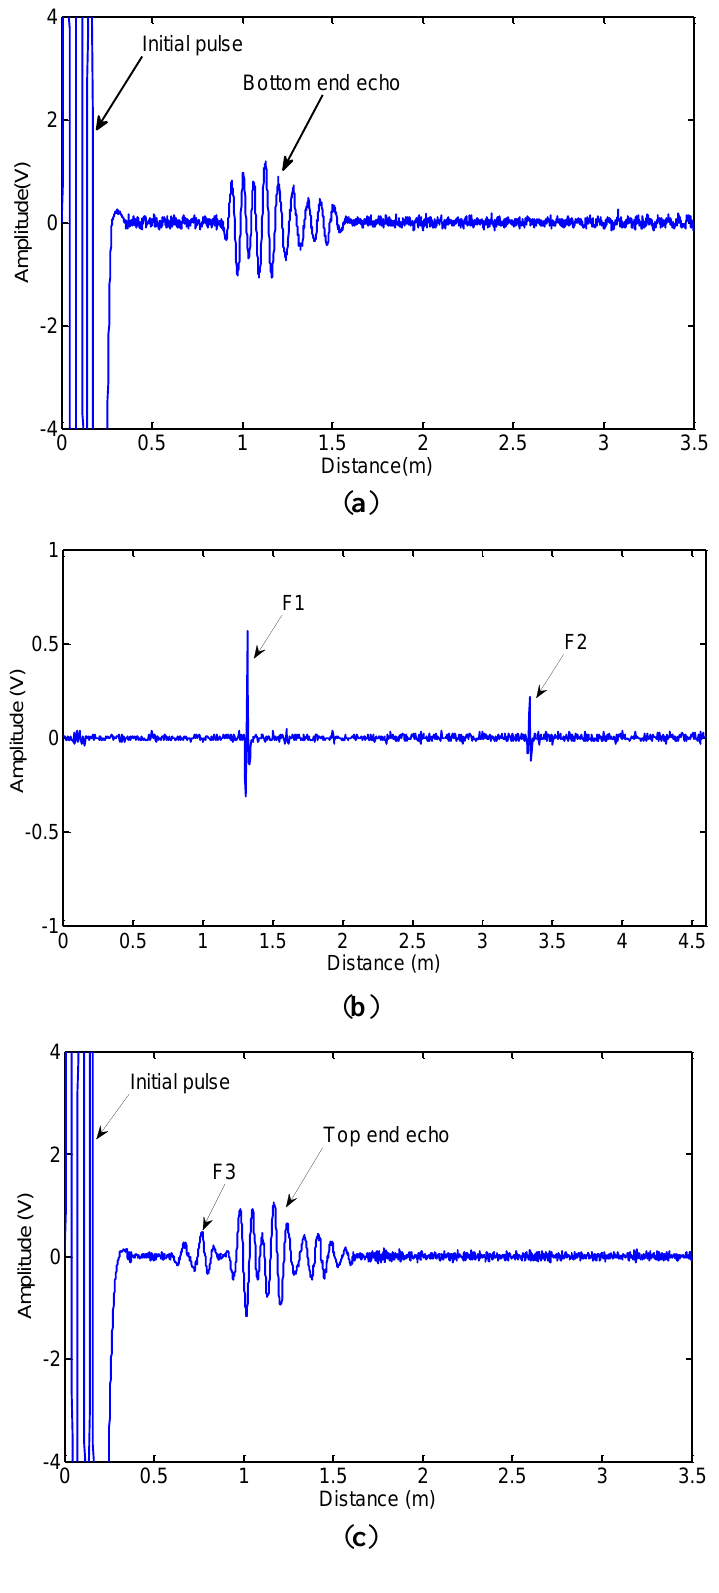
Figure 15. Detection data of the sample cable. ( a ) Data obtained by MGW testing when the transducer stopped at 1.2 m away from the bottom; ( b ) Data obtained by MFL testing when the transducer moved from 1.2 m to 5.8 m away from the bottom; ( c ) Data obtained by MGW testing when the transducer stopped at 1.2 m away from the